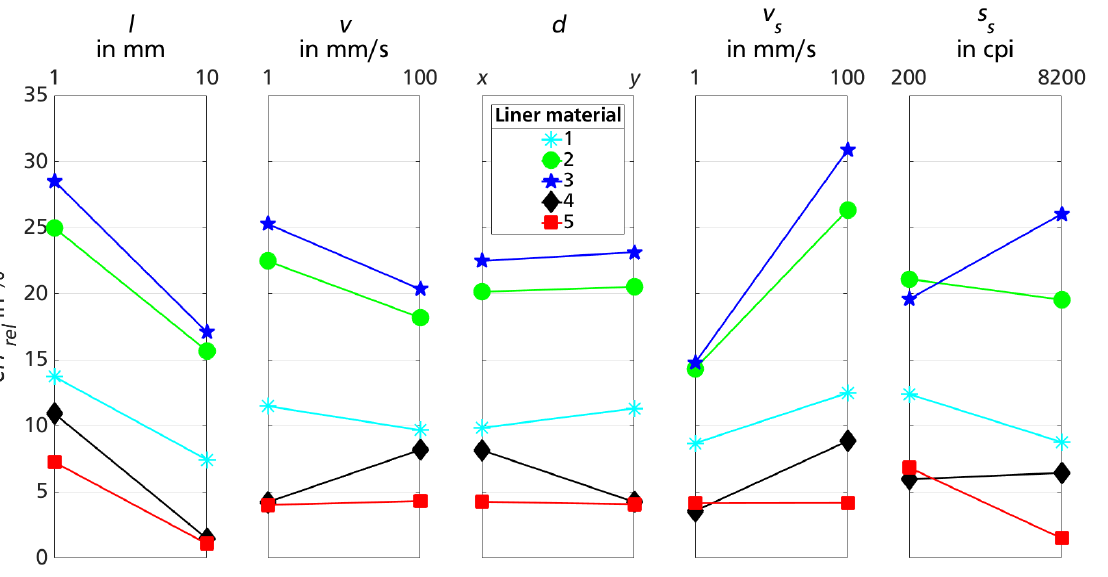
Figure 4. Effect lines for factor variation for measurements of trial session 1 on different liner materials